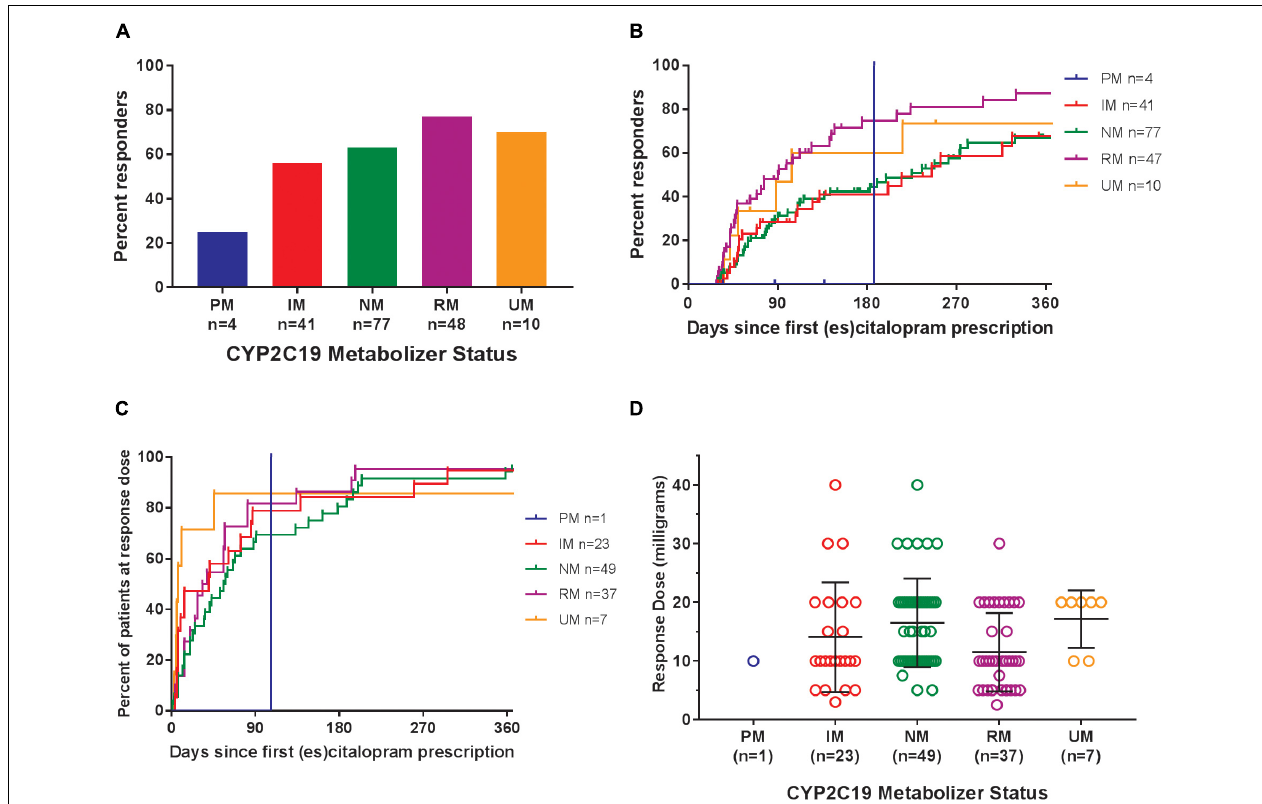
FIGURE 4 | (A) Percentages of patients in the response analysis who achieved or did not achieve a response while prescribed es/citalopram ( p = 0.12, χ 2 ). (B) Time to response was associated with CYP2C19 metabolizer status ( p = 0.005, log-rank test for trend). (C) Time to response dose among patients who achieved a response was not different by CYP2C19 metabolizer status ( p = 0.27, log-rank test for trend). (D) Response dose was not associated with CYP2C19 metabolizer status ( p = 0.67, one-way ANOVA with test for trend). Mean and standard deviation are indicated by the bar and whiskers. PM, poor metabolizer; IM, intermediate metabolizer; NM, normal metabolizer; RM, rapid metabolizer; UM, ultrarapid metabolizer; n ,